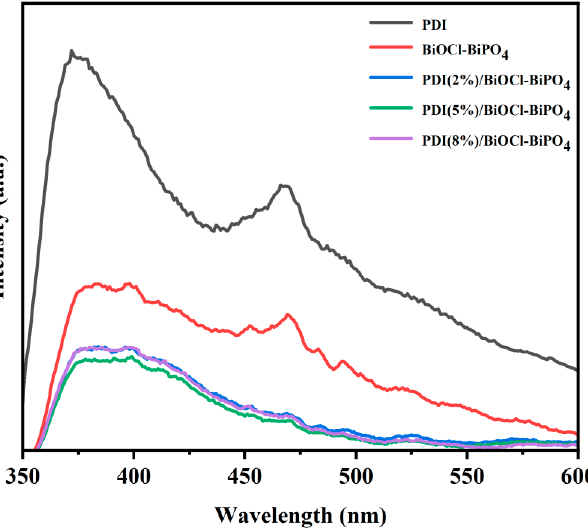
Figure 9. Steady-state fl uorescence spectra of PDI, BiOCl-BiPO 4 , PDI(2%)/BiOCl-BiPO 4 , PDI(5%)/BiOCl-BiPO 4 and PDI(8%)/BiOCl-BiPO 4 samples.